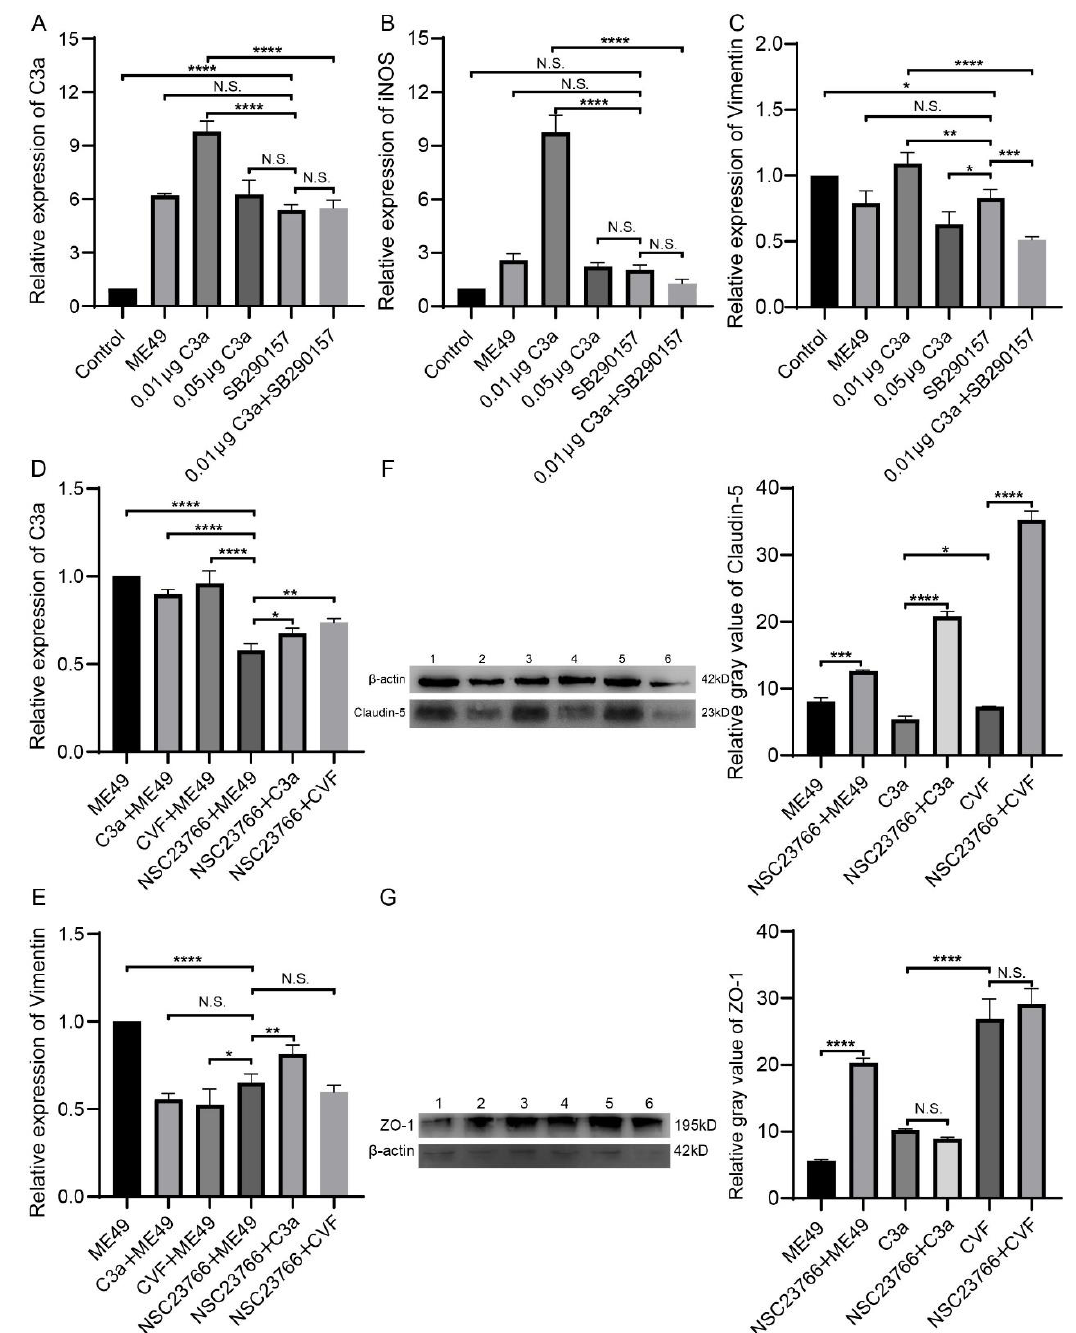
Figure 2. The addition of SB290157 inhibited the promoting effect of low concentration C3a on the expression of C3a, iNOS, and Vimentin in bEnd3 cells, the addition of NSC23766 inhibited the promoting effect of ME49 on the expression of C3a and Vimentin and promoted the expression of TJ proteins (ZO-1 and Claudin-5). ( A – C ) The expression of C3a, iNOS, and Vimentin in bEnd3 cells which were treated with ME49, C3a, and SB290157, the relative expressions were used β-Actin to normalized. ( D – G ) The expression effect of C3a, Vimentin, and TJ proteins in bEnd3 cells which were treated with ME49, C3a, CVF, and NSC23766. The gene expressions were determined by quantitative PCR ( D , E ), and the relative expressions were normalized by β -Actin. The protein expressions were measured by Western blotting. Gray values were analyzed by ImageJ software. ( F , G ). Statistical differences were analyzed by one-way ANOVA. N.S. p ≥ 0.05, * p < 0.05, ** p < 0.01, *** p < 0.001, **** p <